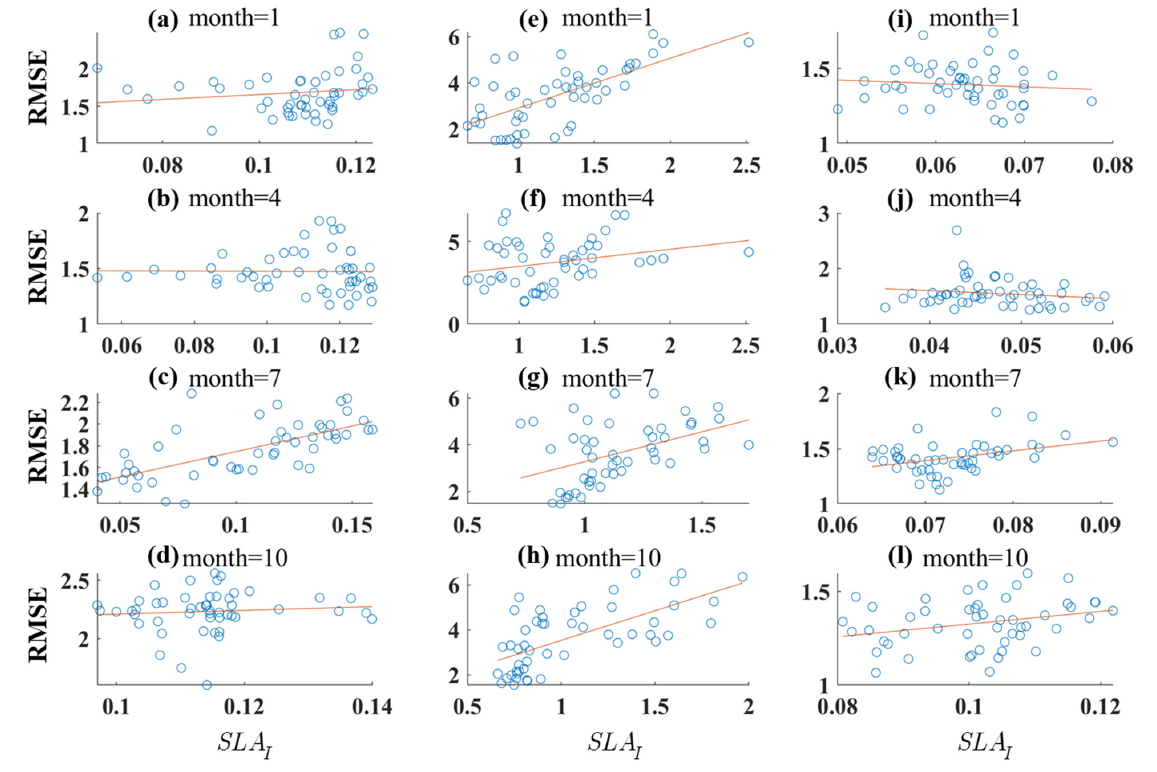
Figure 5. The relationship between SLA I (m) and RMSE (m/s) in Areas A ( a – d ), B ( e – h ), and C ( i – l ) in January, April, July, and October. The blue circles denote the scattered RMSE points in grids.